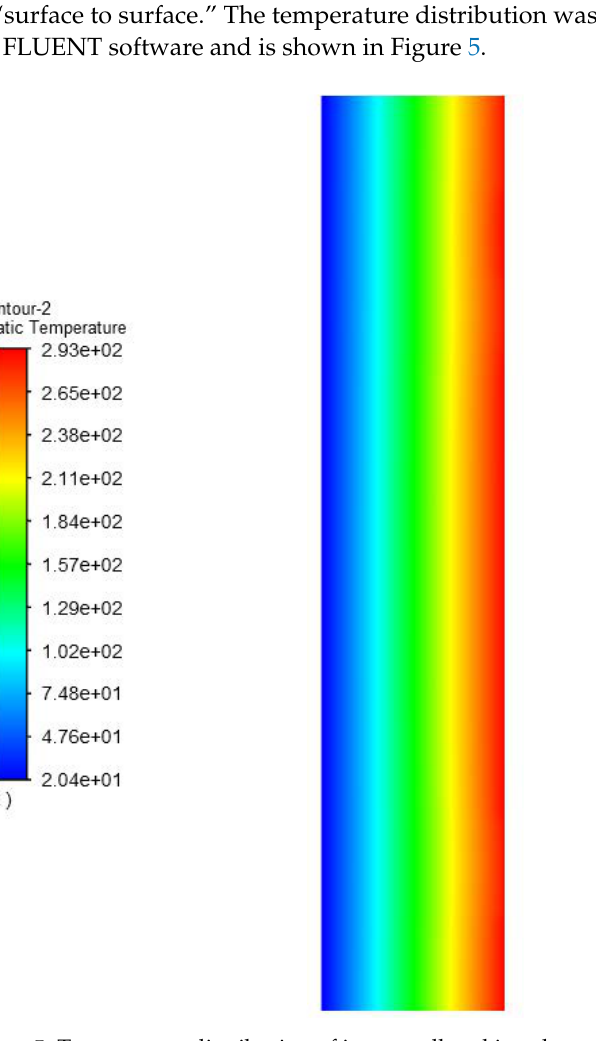
Figure 5. Temperature distribution of inner wall and interlayer thermal insulation materials at the end of